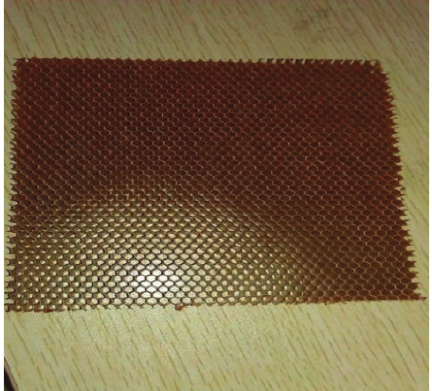
Figure 5: Nomex honeycomb.